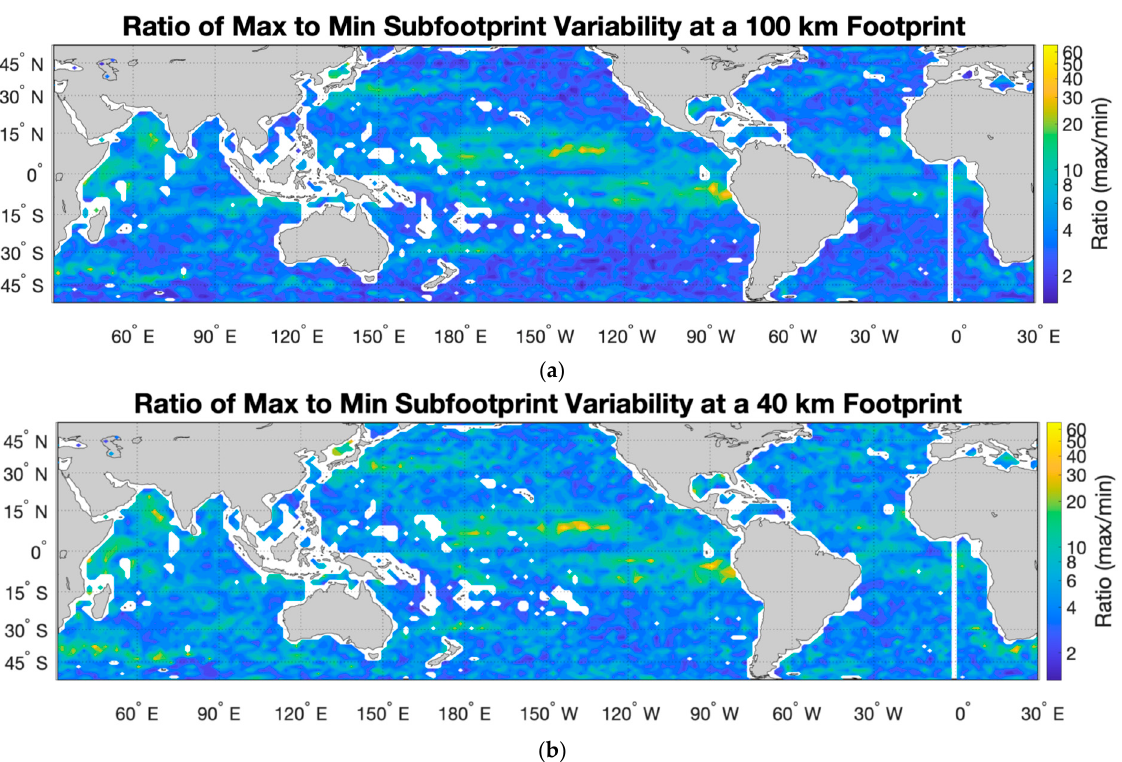
Figure 8. Ratio of maximum monthly median SFV to minimum monthly median SFV for ( a ) 100 and ( b ) 40 km footprint size. Note the uneven logarithmic color scale on the right.